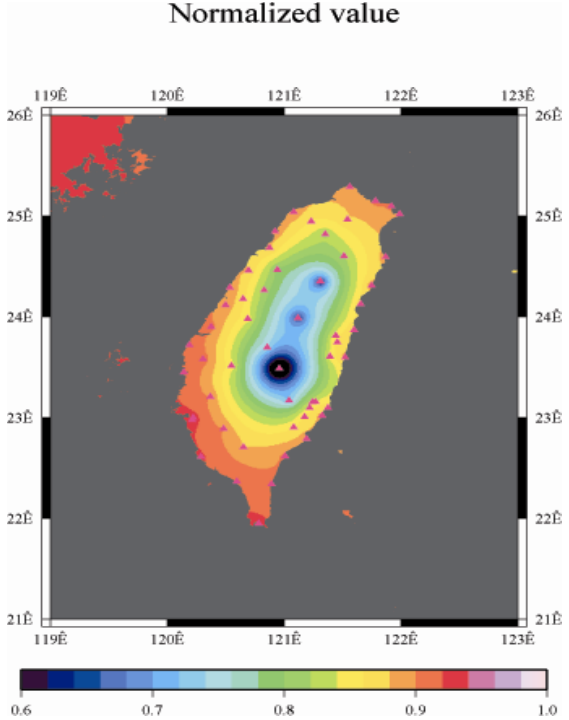
Figure 18. Normalized ZTD values around the island during plum rains (June 2nd, 2008, 1:00 PM).